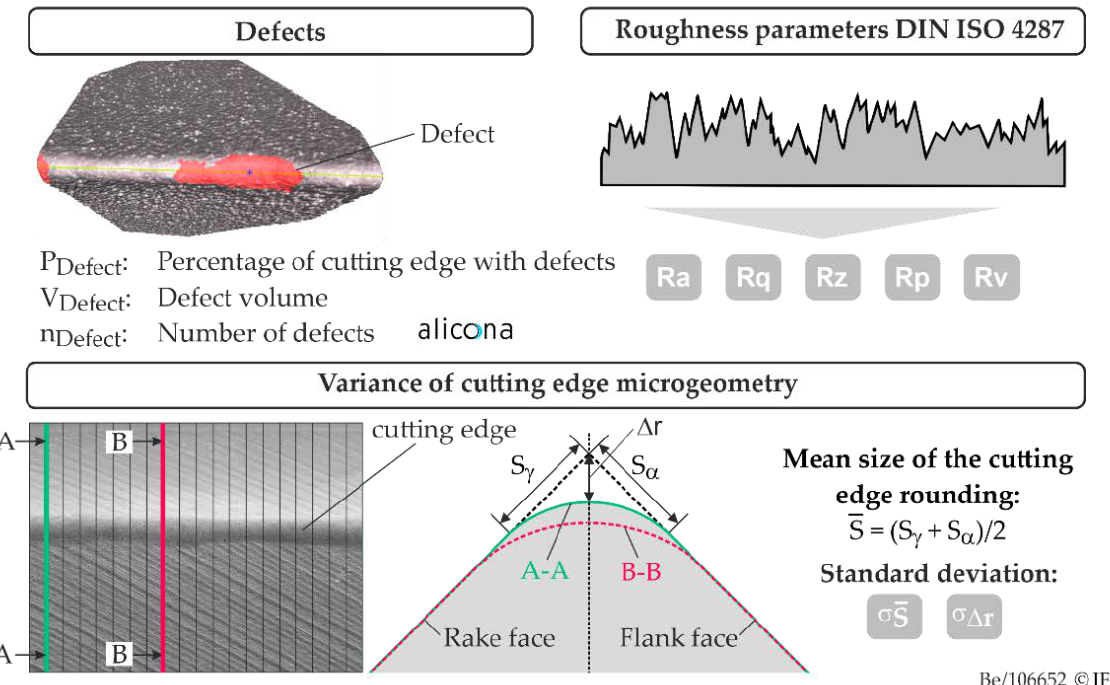
Figure 9. Overview of potential parameters for the chipping.